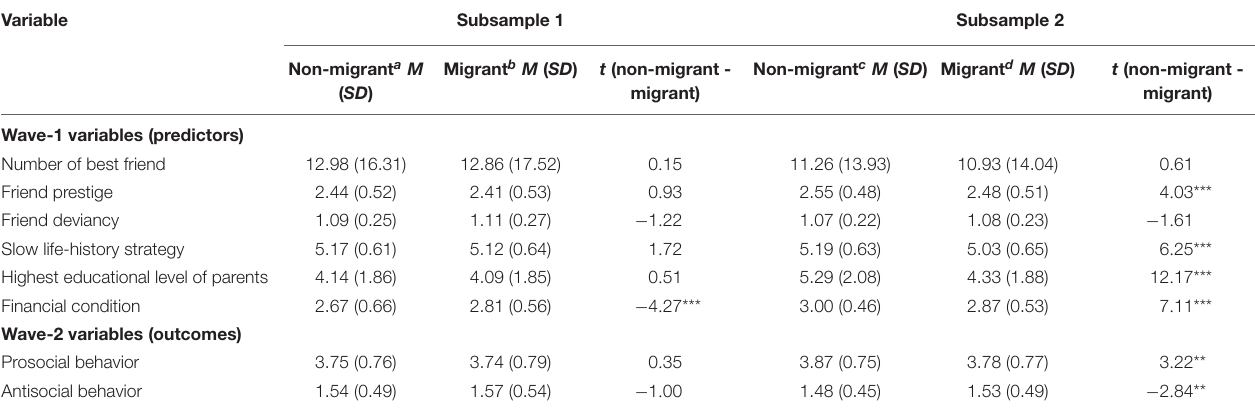
TABLE 2 | Means (M) and standard deviations (SD) for the variables and comparison between non-migrant and migrant students.